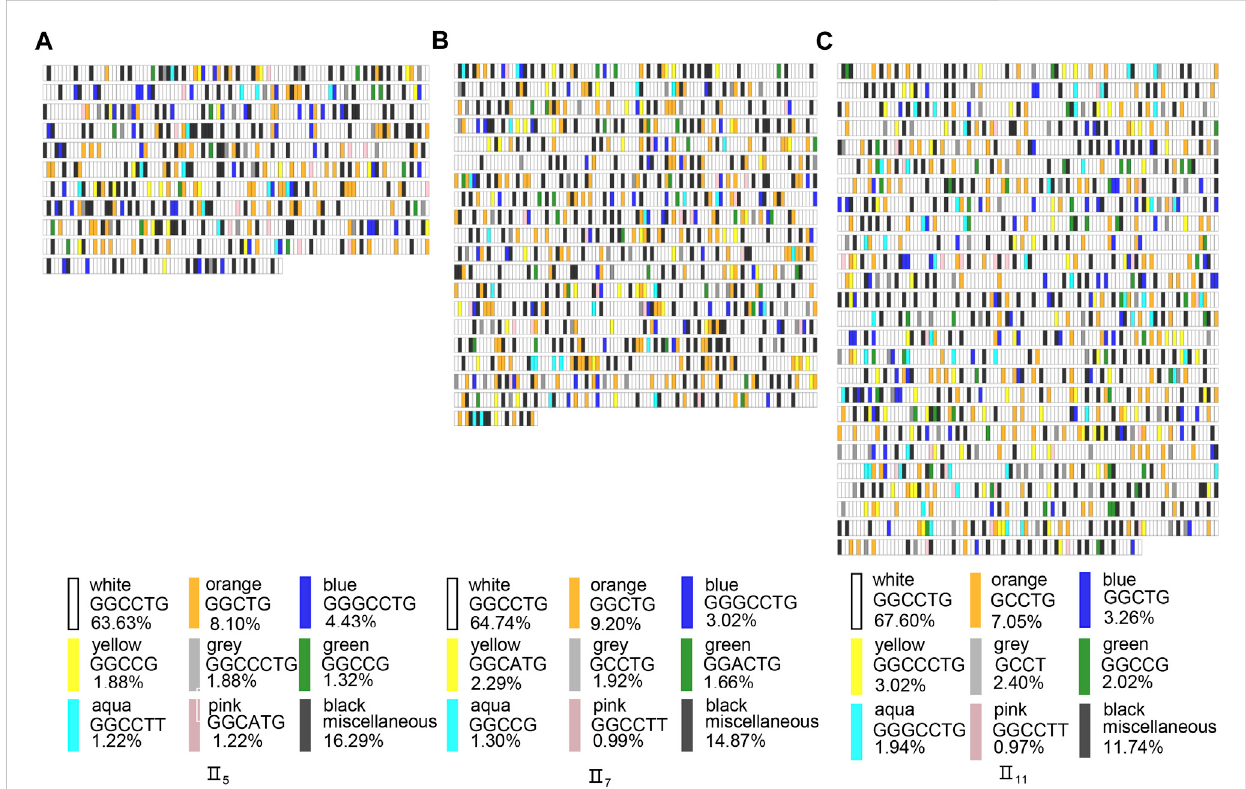
FIGURE 5 NOP56 repeat expansion sequence schematics based on long-read sequencing with the highest GGCCTG repeat number full-length subreads of threepatients.TheschematicsandexpansionsizeshownarebasedonthehighestGGCCTGnumberofrepeatsforthepatientsinthepedigreeasfollows: II 5 (A) , II 7 (B) , II 11 (C) . The Rectangles represent sequence motifs, as indicated by the color key, in the 5 ’ (upper left) to 3 ’ (lower right) direction. Black rectangles indicated the motif is less than 1% of all the full-length